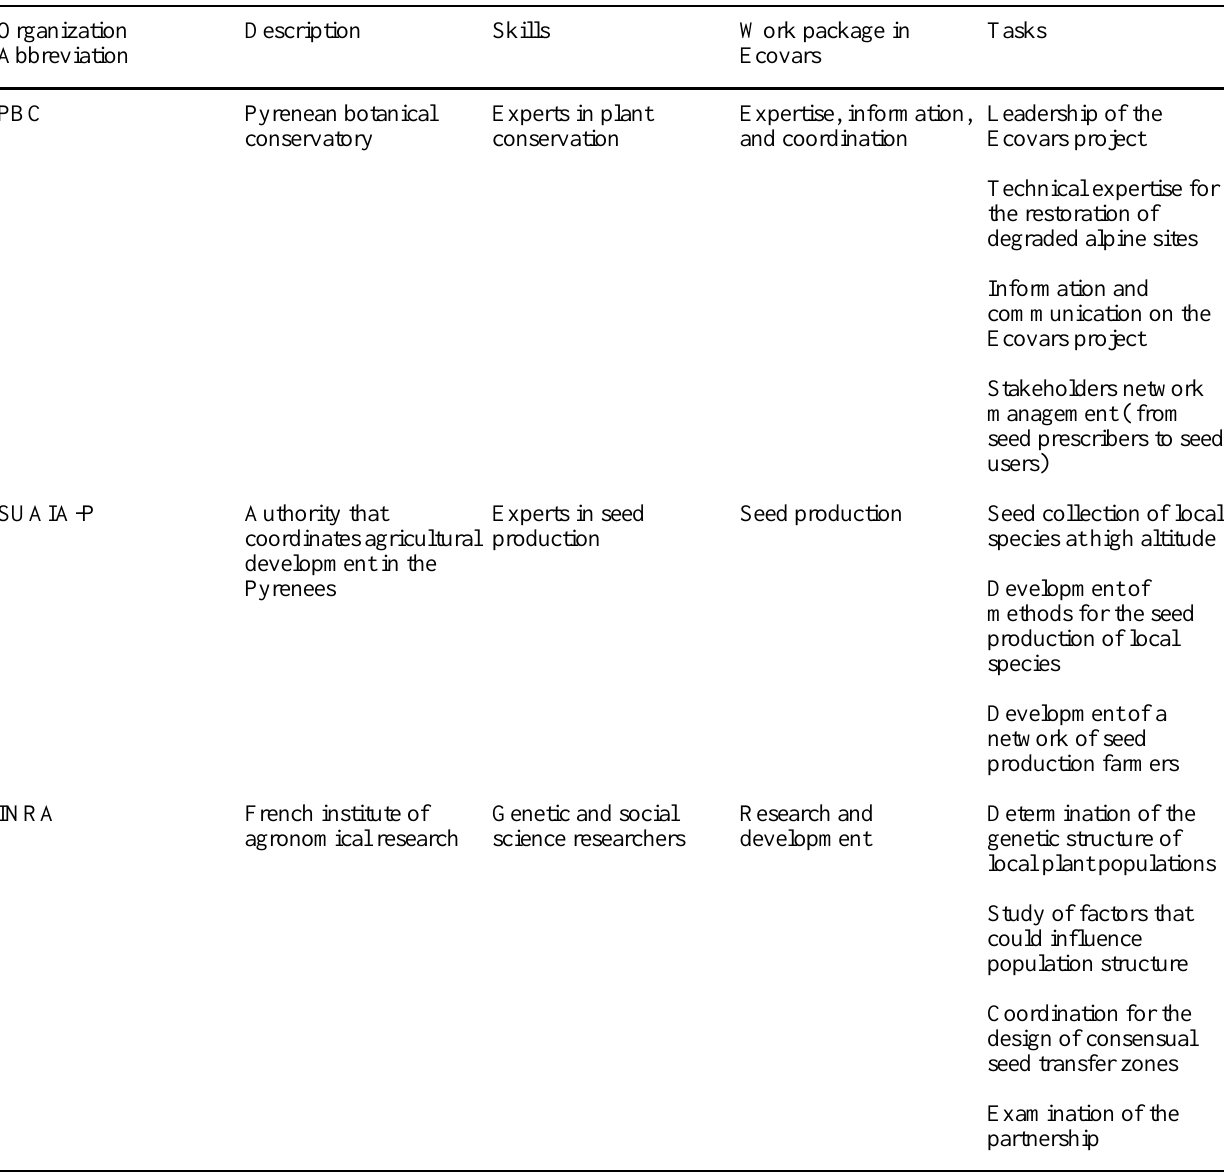
Table 1. Organization of the Ecovars project in three work